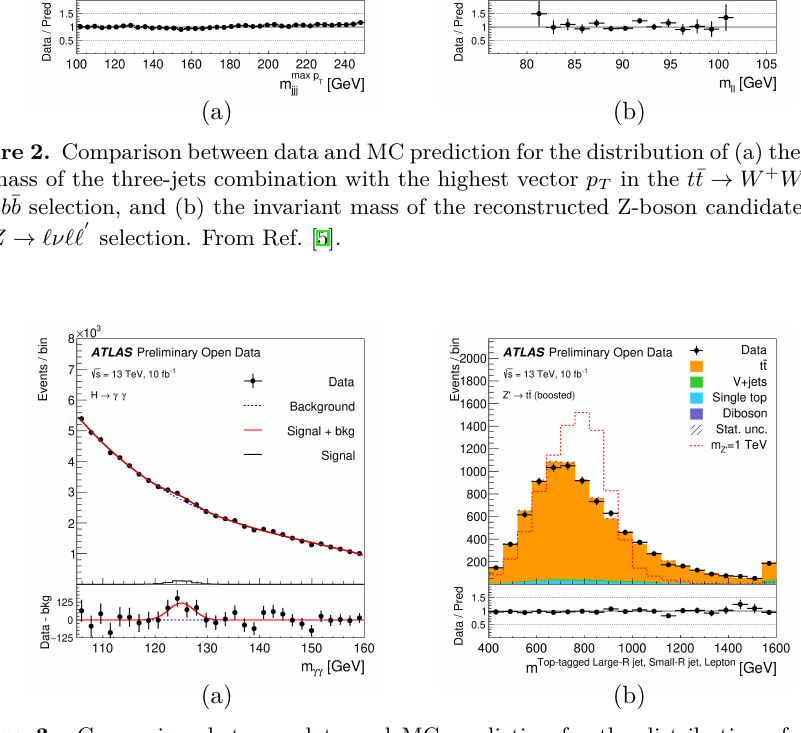
Figure 3. Comparison between data and MC prediction for the distribution of (a) the diphoton invariant-mass spectrum in the H ! (cid:13)(cid:13) selection, and (b) the approximate mass of the t (cid:22) t system in the new heavy Z ′ ! t (cid:22) t single-lepton boosted selection. From Ref.